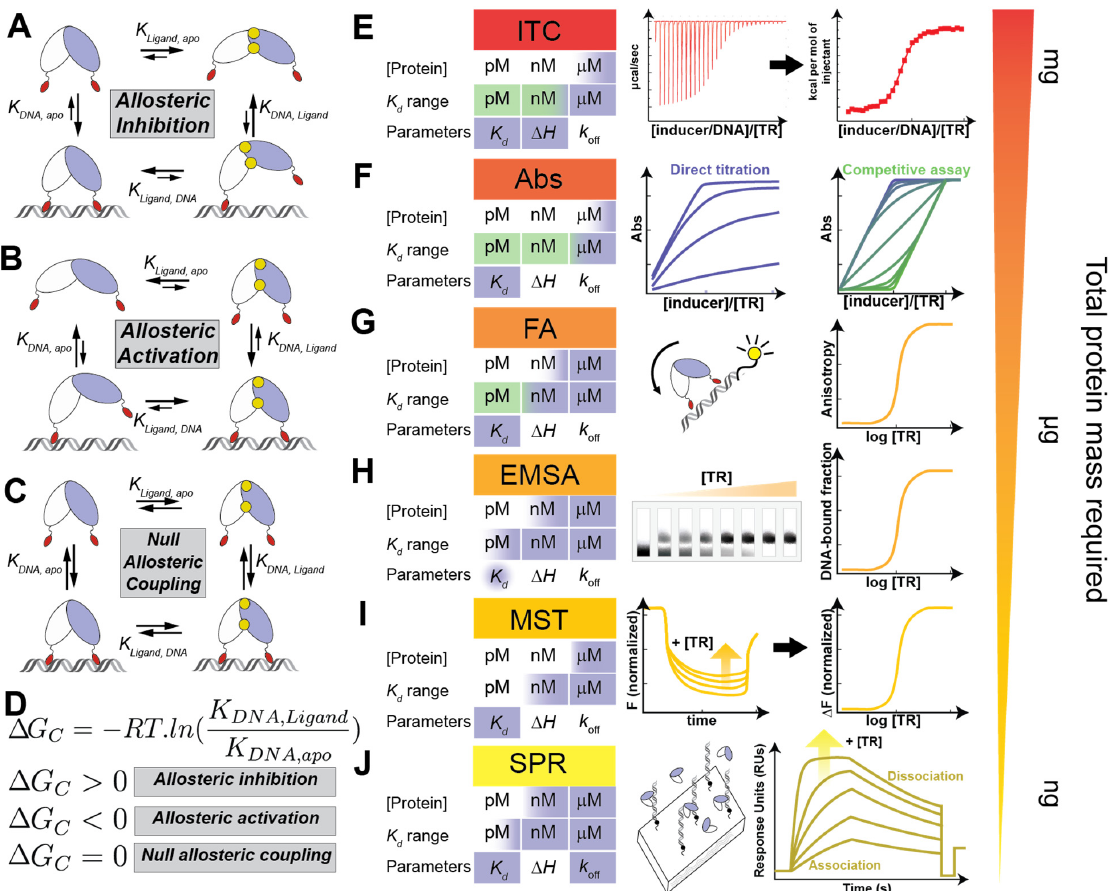
Figure 2. Ligand-binding processes and techniques of interest in transcriptional regulator characterization. ( A – D ) General thermodynamic cycles that account for linkage between the four